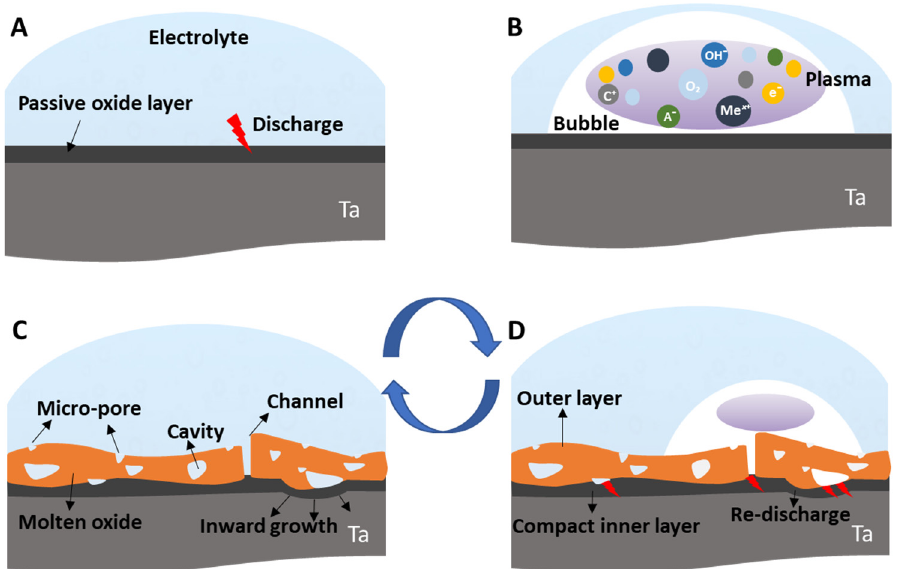
Figure 1. Schematic illustration of the representative growth mechanism of the Ta 2 O 5 coating by MAO: ( A ) start of the spark discharges after the rapid formation of the oxide layer; ( B ) formation of the bubble and ignition of the plasma; ( C ) new oxide formation; ( D ) start of the new discharges with a generation of a gas bubble and plasma, leading to the formation of the new oxide coating.